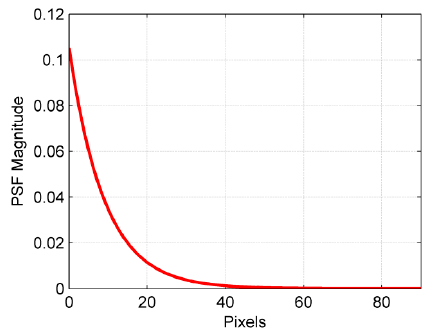
Figure 4. Normalized point spread function (PSF) at atmospheric pressure with a rotational frequency f = 269 Hz and length of 10 lifetimes (adapted from Gregory et al.